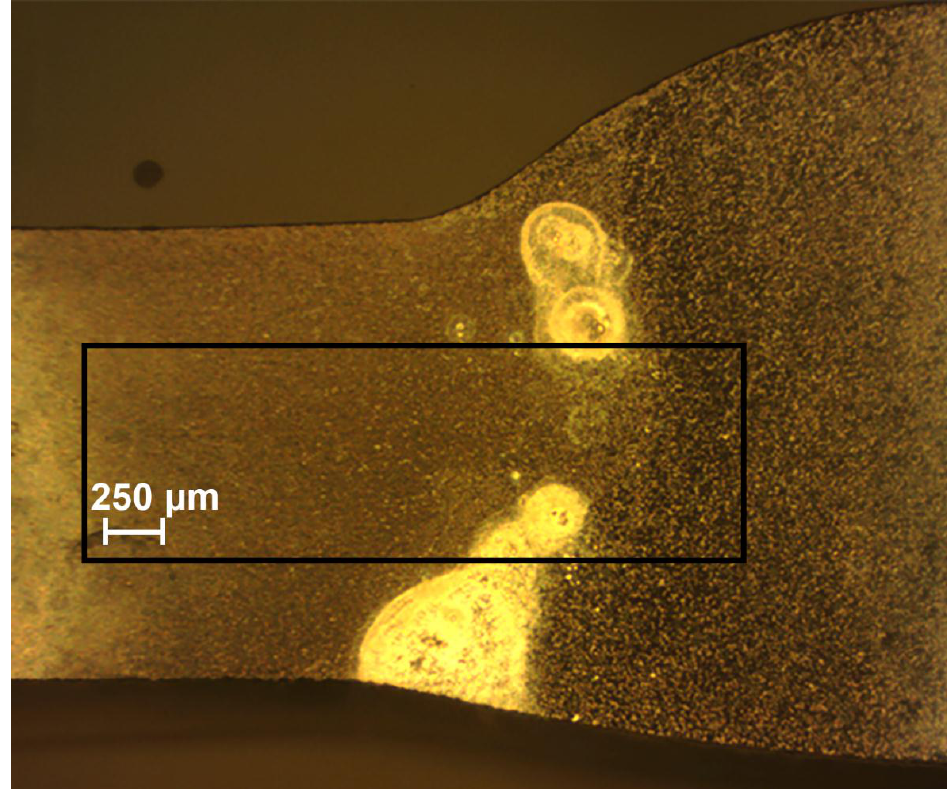
Figure 6. The optical image of the investigated area of the welded joint of the 1579 aluminium alloy sample after 510 min of immersion in 0.5 M NaCl solution. There is a development of the corrosion process within the weld interface. process within the weld